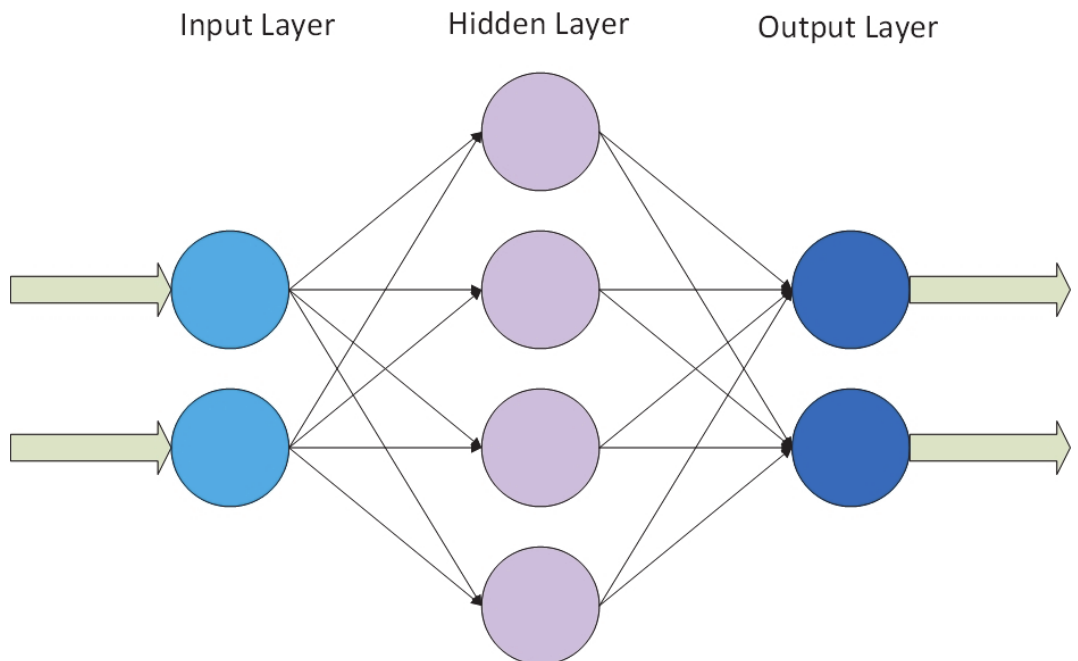
Fig. 3. Multi-Layer Perceptron(MLP)